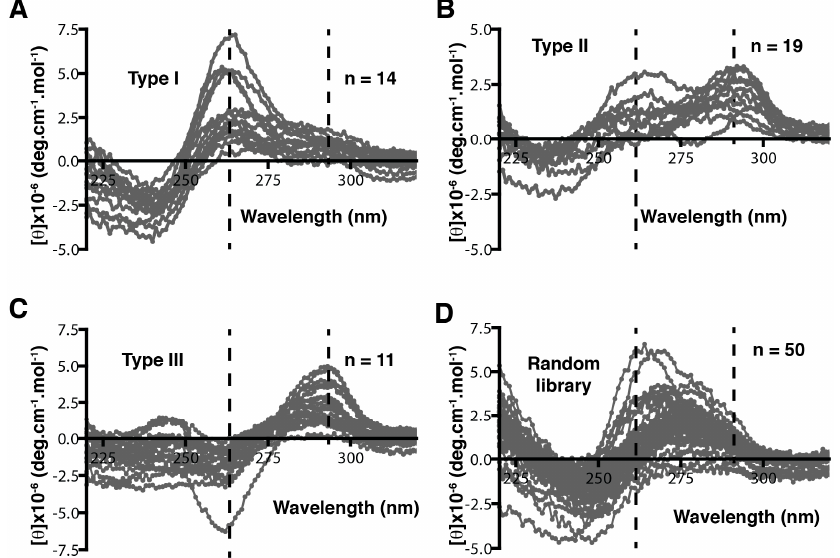
Figure 4. Circular dichroism (CD) characteristics of different quadruplexes and random library. ( A ) Parallel quadruplex shows positive peaks at 265 and 295 nm; ( B ) antiparallel quadruplex with glycosidic bond angles of the same orientation shows bimodal spectra as positive peaks at 265 nm and 295 nm of the same intensity; ( C ) antiparallel quadruplex with glycosidic bond angles of opposite orientation—the CD shows a negative peak at 265 nm and a positive peak at 295 nm; ( D ) random library shows a peak at 280 nm but no peaks at 265 nm and 295 nm, indicating the absence of a quadruplex. Figure adapted from McManus and Li [78]. Table 2. Major open-source programs for SELEX (Systematic Evolution of Ligands by Exponential Enrichment) HTS (high-throughput sequencing) data analysis.